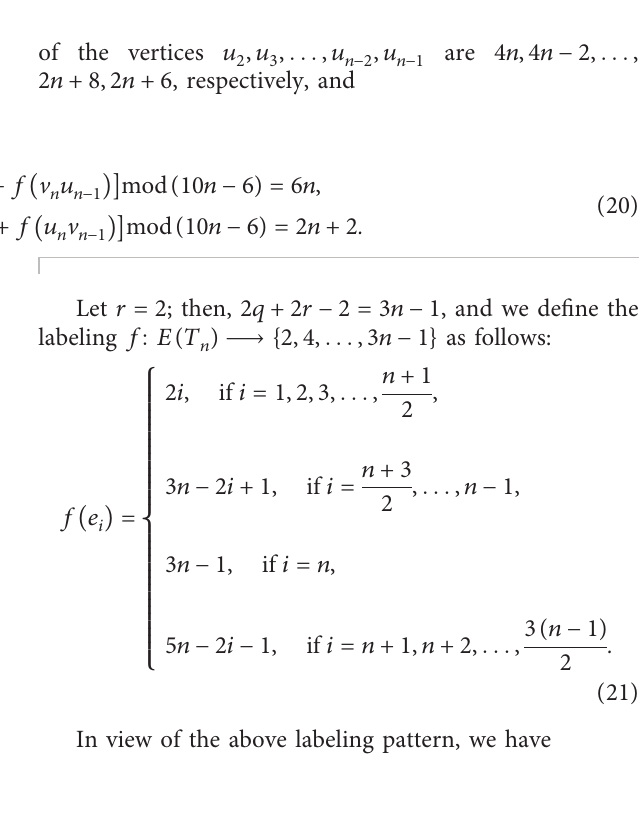
n with ordinary